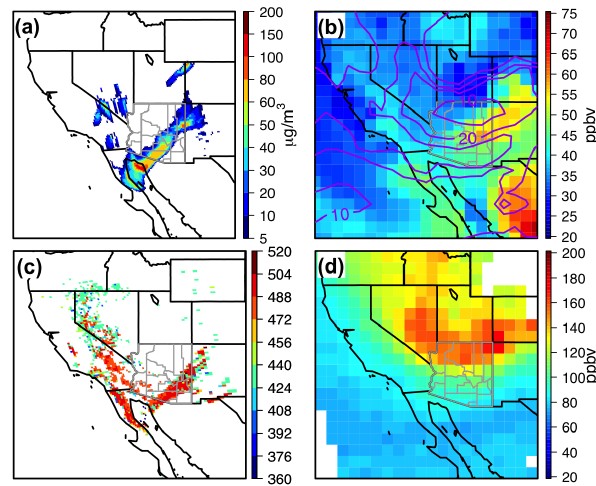
Figure 7. (a) CMAQ modeled dust contributions to PM2.5 and (b) RAQMS modeled surface ozone at 11:00 mountain stan- dard time on 11 May 2014. The purple contour lines in (b) in- dicate RAQMS relative humidity (%) at the upper troposphere ( ∼ 300hPa). (c) and (d) indicate, respectively, the AIRS daytime (early afternoon overpass time) dust score and ozone concentra- tions at 300hPa. Following the criteria at http://disc.sci.gsfc.nasa. gov/nrt/data-holdings/airs-nrt-products, the dust score values below 360 were